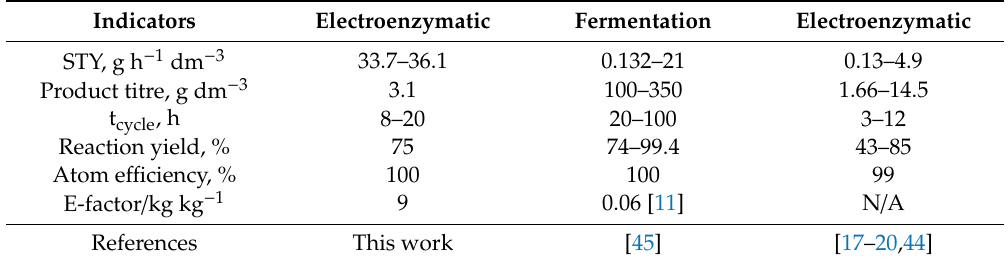
Table 5. Comparison of di ff erent processes for the gluconic acid